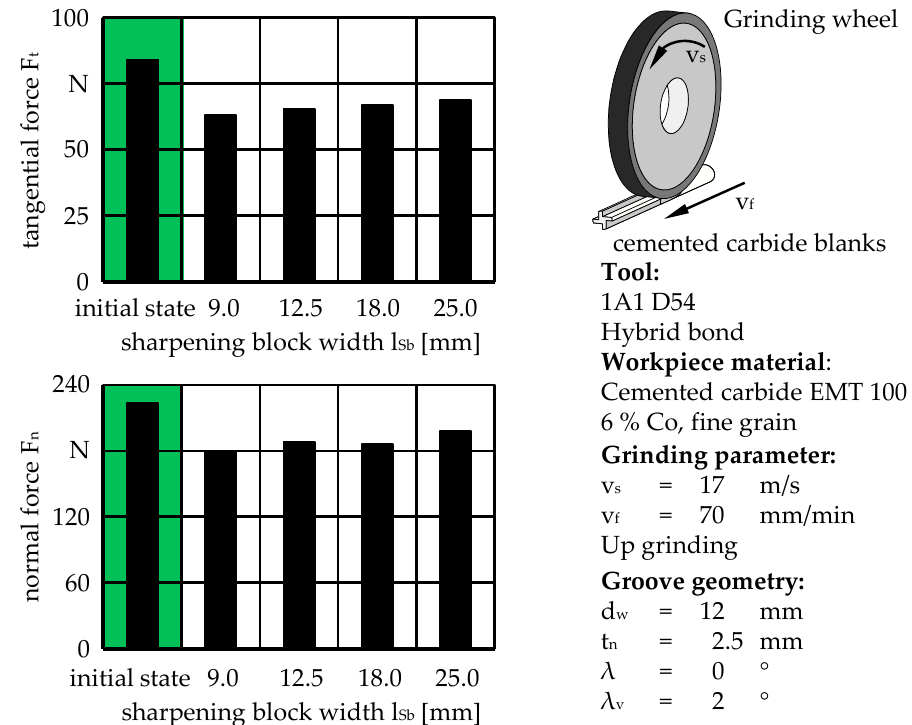
Figure 11. Influence of the sharpening block width l Sb on the grinding forces.